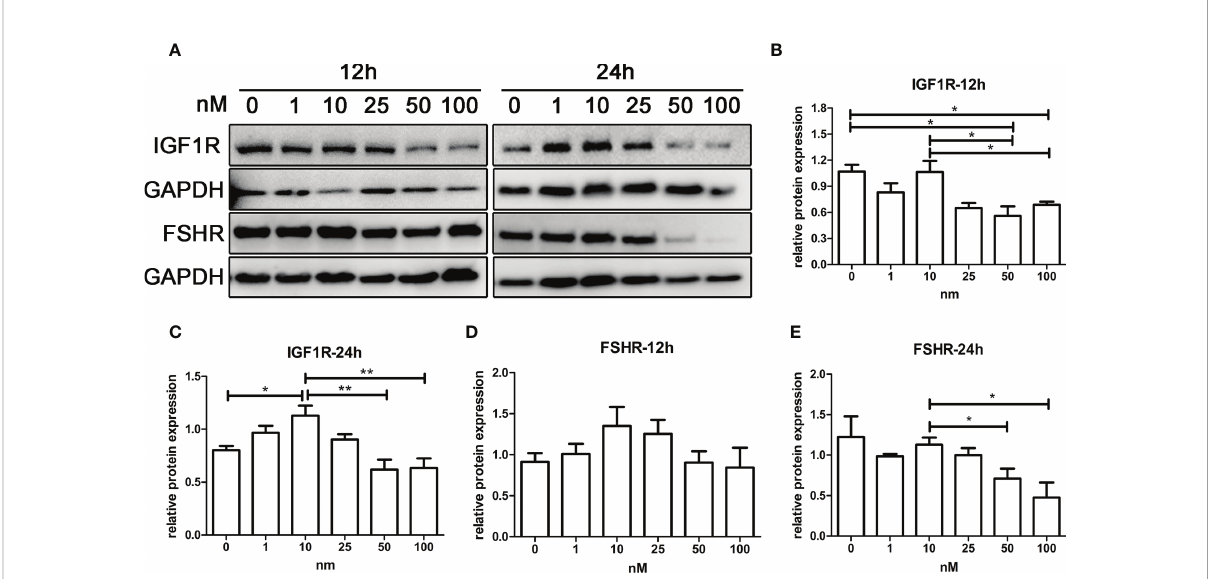
FIGURE 6 The effect of androgens on the expression of FSHR and IGF1R of KGN cells. KGN cells were treated with solvent or 1, 10, 25, 50, and 100 nM DHT. The cells were collected for Western blot analysis (A) to determine the IGF1R (B, C) and FSHR (D, E) protein levels after 12 and 24 h. n = 3 in each time point and each group; one-way ANOVA. *P < 0.05, **P <